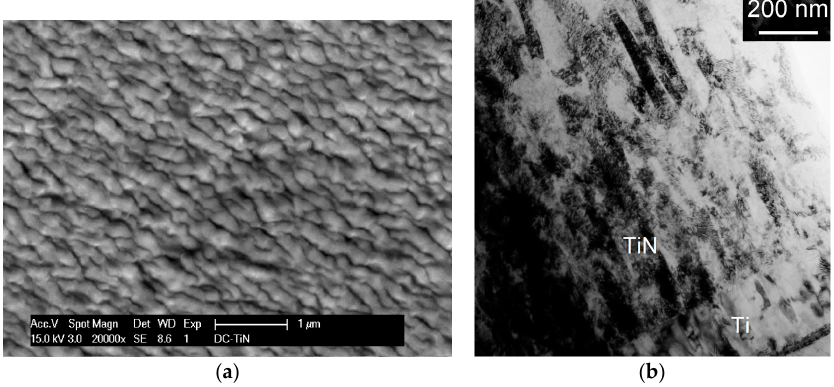
Figure 2. ( a ) A FEG ‐ SEM (field ‐ emission ‐ gun scanning electron microscopy) micrograph of the TiN coating surface; ( b ) A cross ‐ sectional TEM bright field micrograph of the TiN